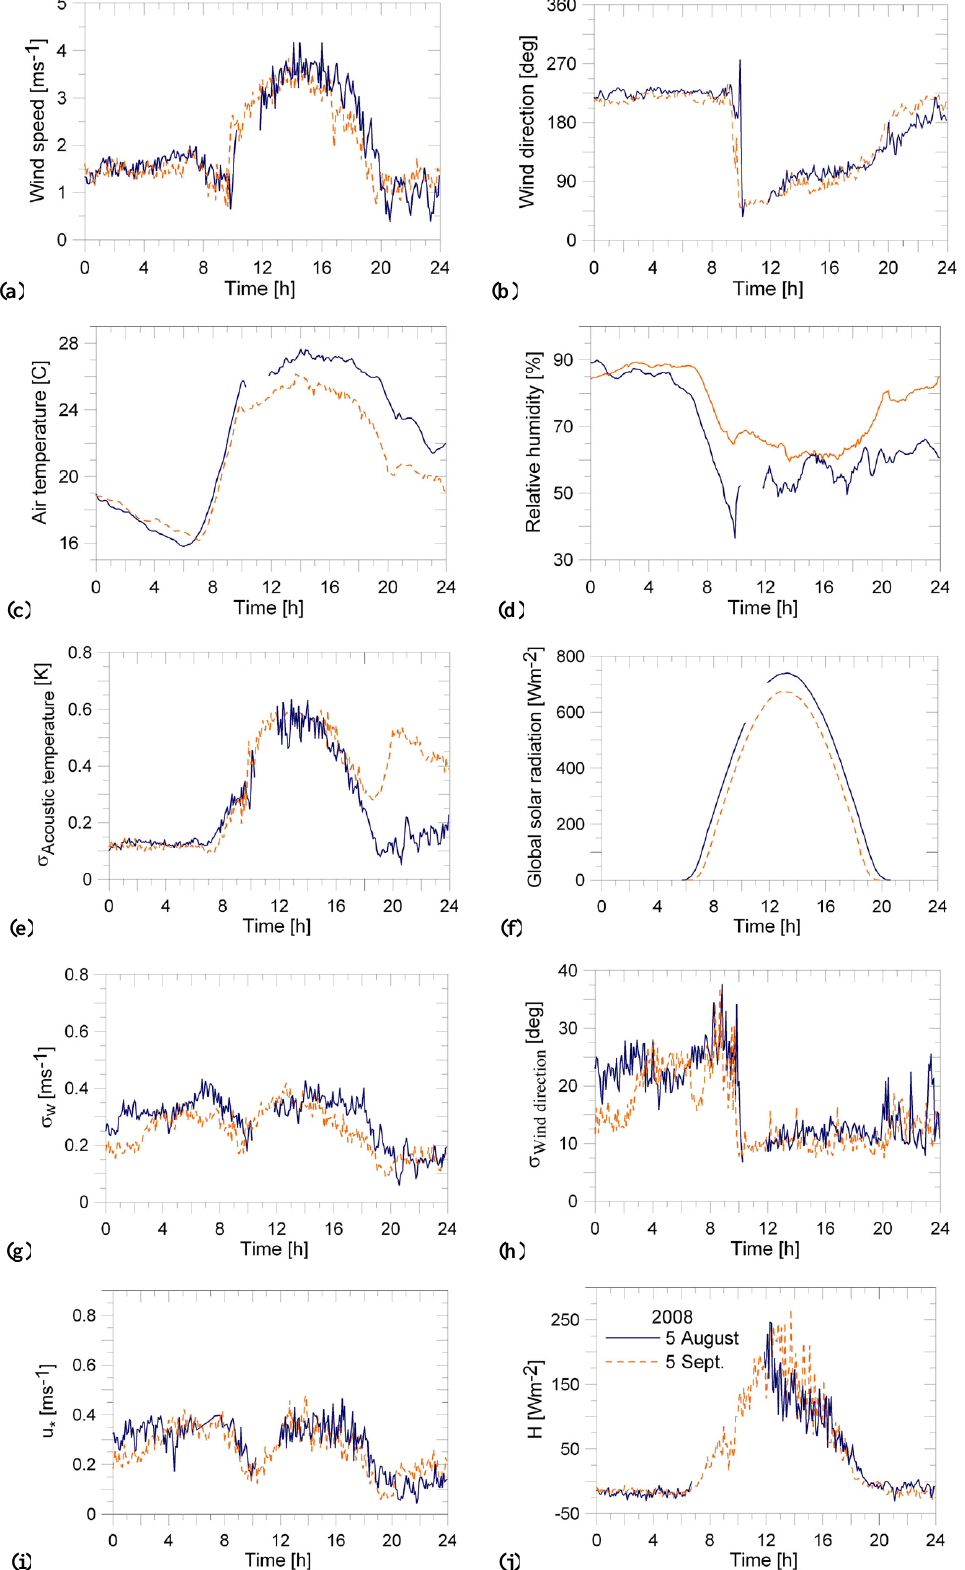
Figure 4. Notation is as in Fig. 3, but for 5 August 2008 (dark blue solid lines) and 5 September 2008 (orange dashed lines).